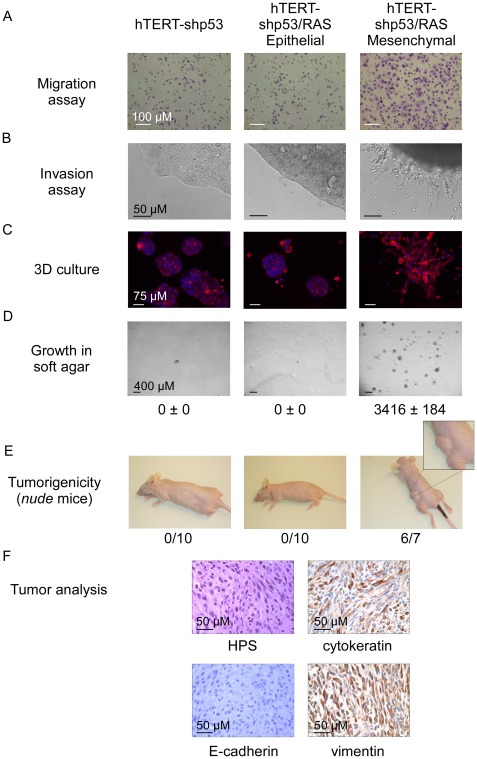
Characterization of epithelial and mesenchymal hTERT-shp53/RAS HMEC-derivative subpopulations.(A, B) Migratory and invasive properties analyses as assessed by Boyden chamber migration and Matrigel invasion assays, respectively. (C) Cellular morphology in 3D culture. (D) Transformation potential analysis assessed by a soft agar colony formation assay. Numbers of colonies are indicated ± SD of triplicate counting. (E) Tumorigenic potential analysis assessed by homotopically xenografts in nude mice. Numbers of mice developing tumors are indicated. (F) Tumor histology: Hematoxylin-Phloxin Saffranin staining (HPS) and cytokeratin, E-cadherin and vimentin expression analysis assessed by immunohistochemistry.